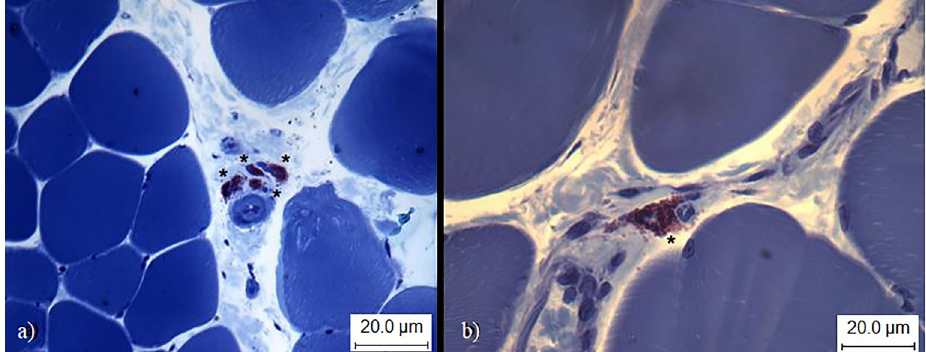
Figure 5. Soleus muscle of sedentary ischemic animals. a , mast cells (asterisks) located in the interstitium; b , mast cell (asterisk). Staining: toluidine blue + sodium borate. Bar: 20.0 m m.